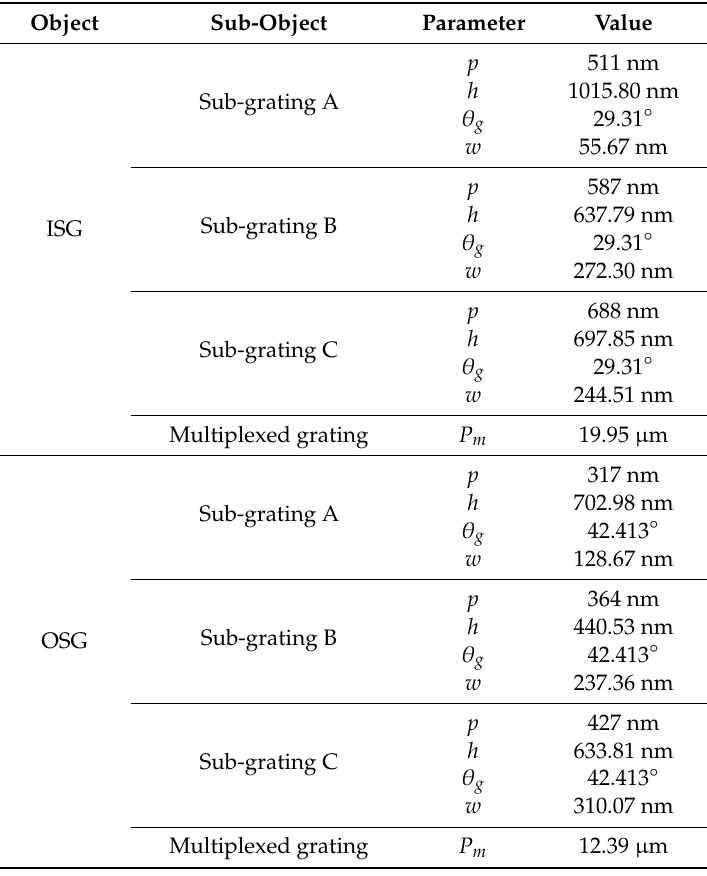
Table 7. Optimized parameters of the ISG and